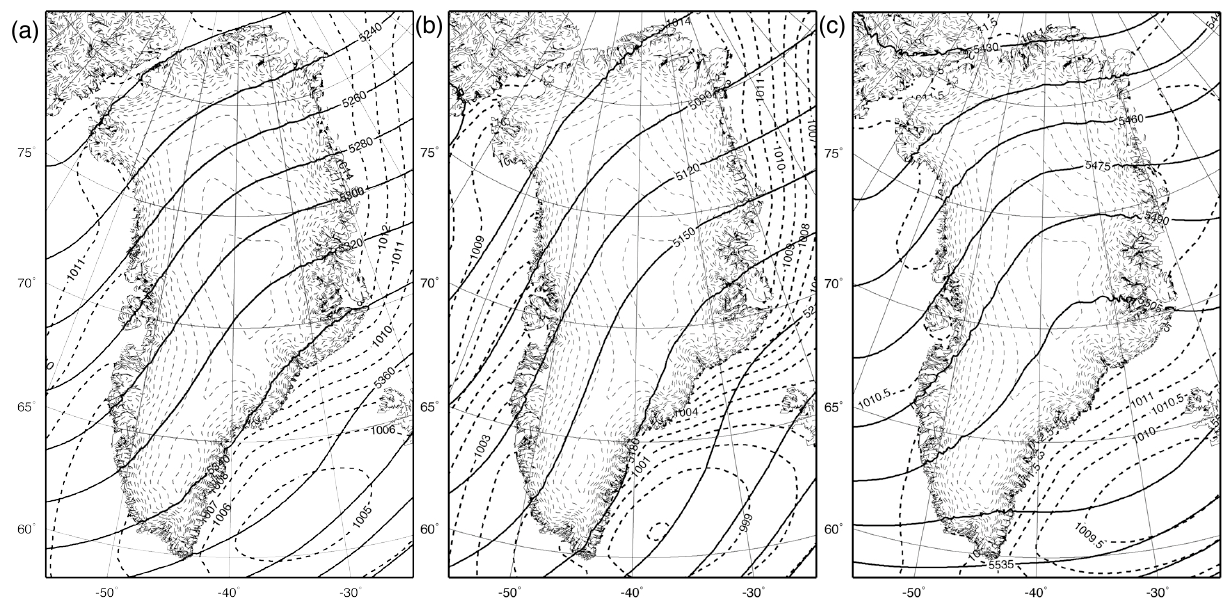
Fig. 1. Mean 500hPa height Z 500 [ma.s.l.; solid contours], sea level pressure p s [hPa; dashed contours over ocean only], topography of the GrIS [m; dashed contours every 250m over land only] averaged over (a) a year, and the seasons (b) DJF and (c) JJA. Note the differences in contour